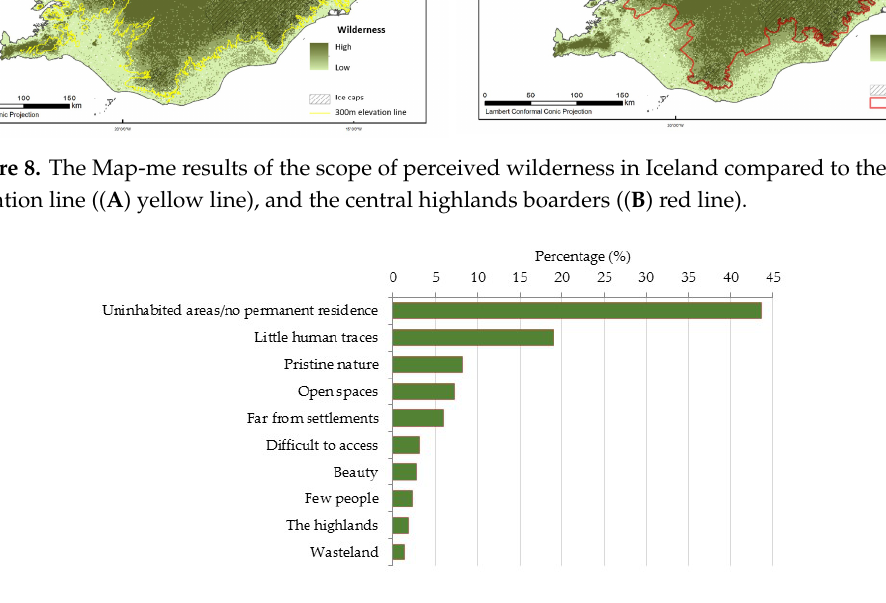
Figure 9. Elements that characterizes areas perceived and mapped as wilderness.